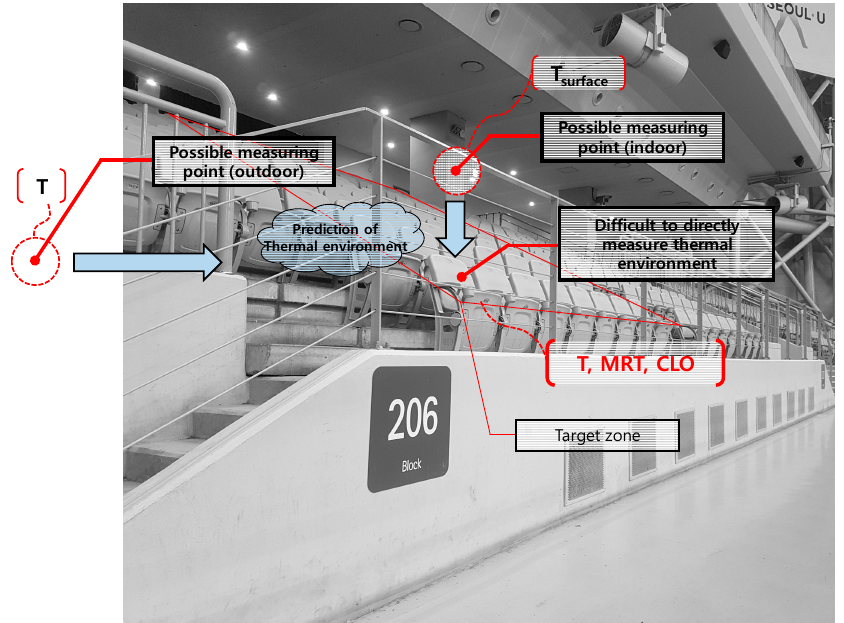
Figure 9. An example of the method for predicting thermal environment in a large space. In a stadium, it can be difficult to directly install measuring devices on the seats. The ANN based prediction algorithm enables user to install measuring devices on easy-to-install locations.